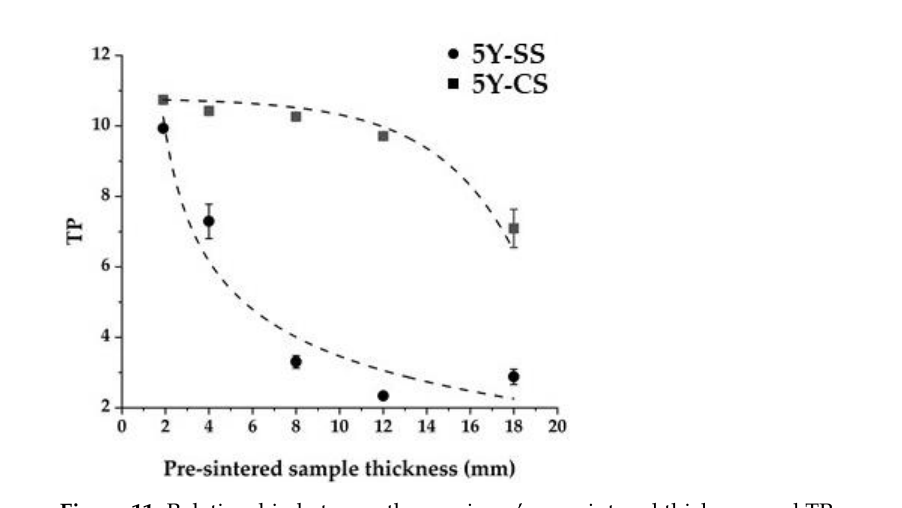
Figure 13. Fracture toughness of 5Y-SS and 5Y CS.